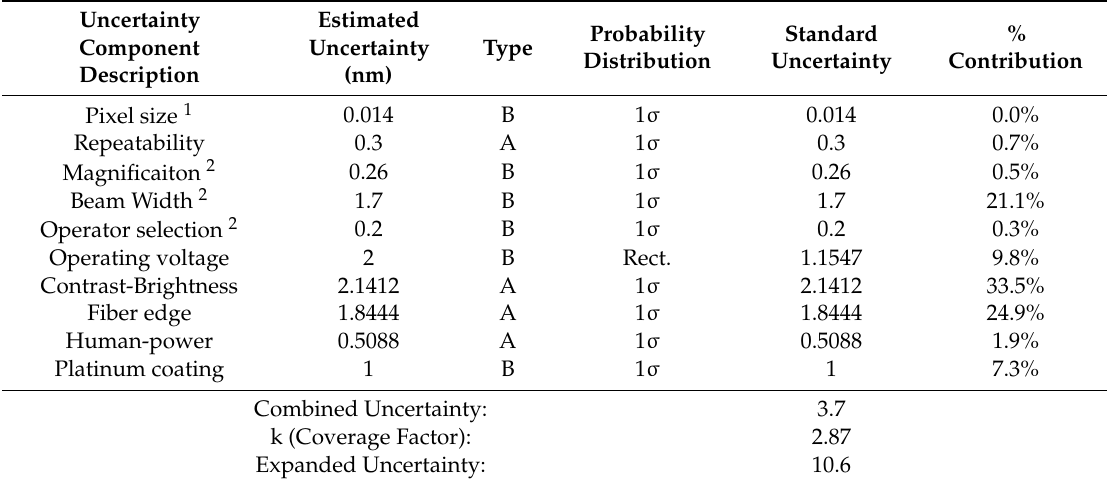
Table A4. Uncertainty budget for measured values presented in relation to Figure A14.